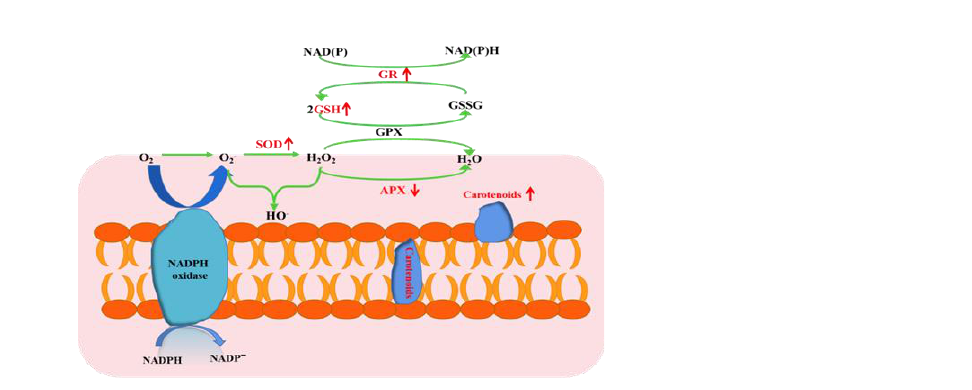
Figure 4. Biochemical reveals Planococcus sp. O5 copper tolerance mechanisms. The down and up arrow means down-regulation and up-regulation, respectively.